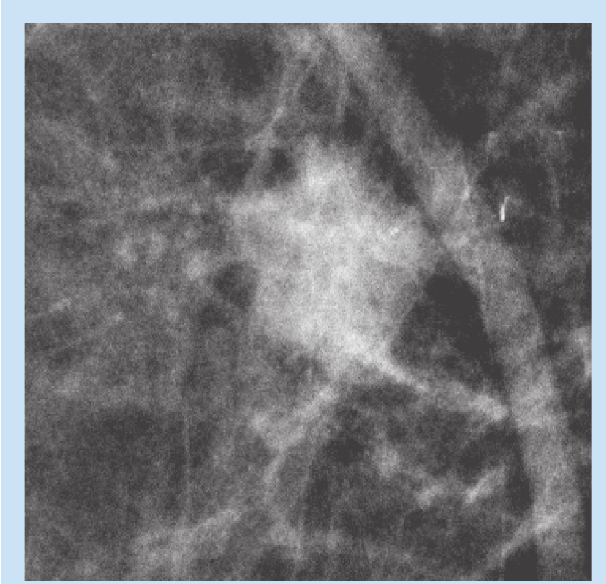
Fig. 6. Patient 6 – clumped, dense calcification pattern (with mass); calcification pattern is benign.